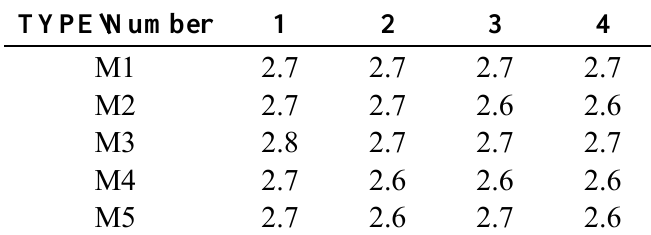
Table 1. Test results of the initial static capacitance